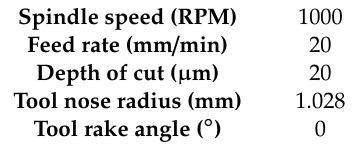
Table 3. The selected cutting parameters for the ultra-precision turning experiments.